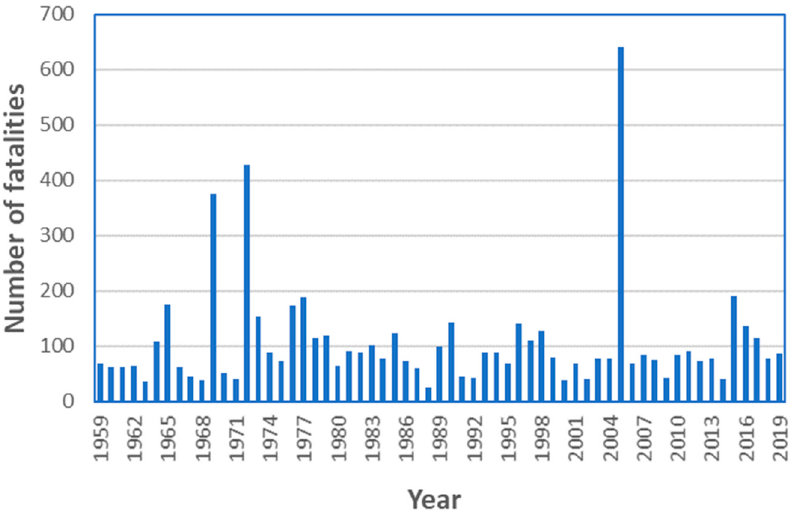
Figure 4. Annual flood fatalities in the contiguous US (1959–2019).